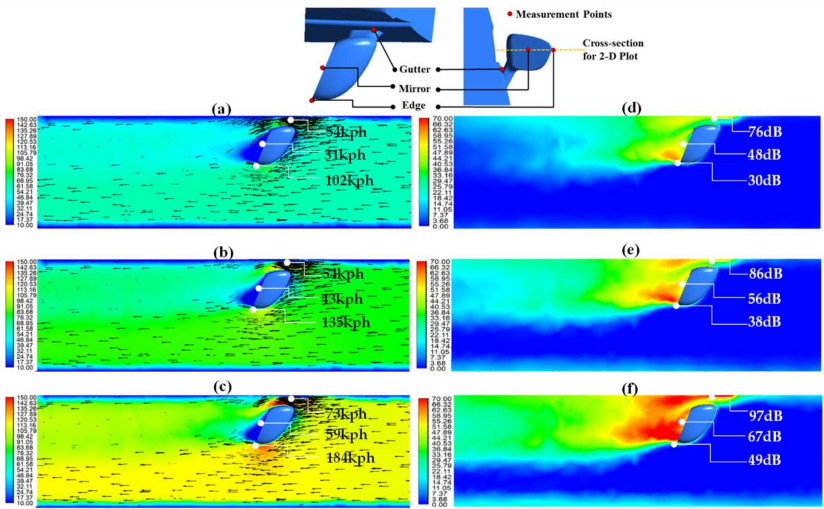
Figure 3. Flow velocity contour with vector field ( a – c ) and maximum sound pressure level ( d – f ) around the reference outside rear view mirror (OSRVM) model at 23 ◦ C and 50% humidity conditions for three vehicle speeds: ( a , d ) 60 kph, ( b , e ) 80 kph, and ( c , f ) 110